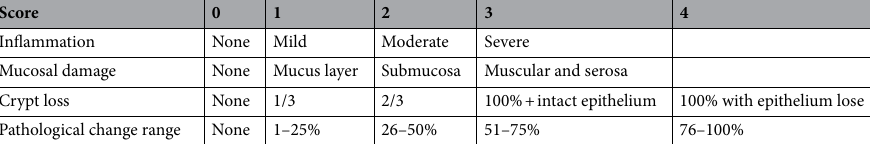
Table 2. Histopathological criteria used for colorectal tissue damage scoring.